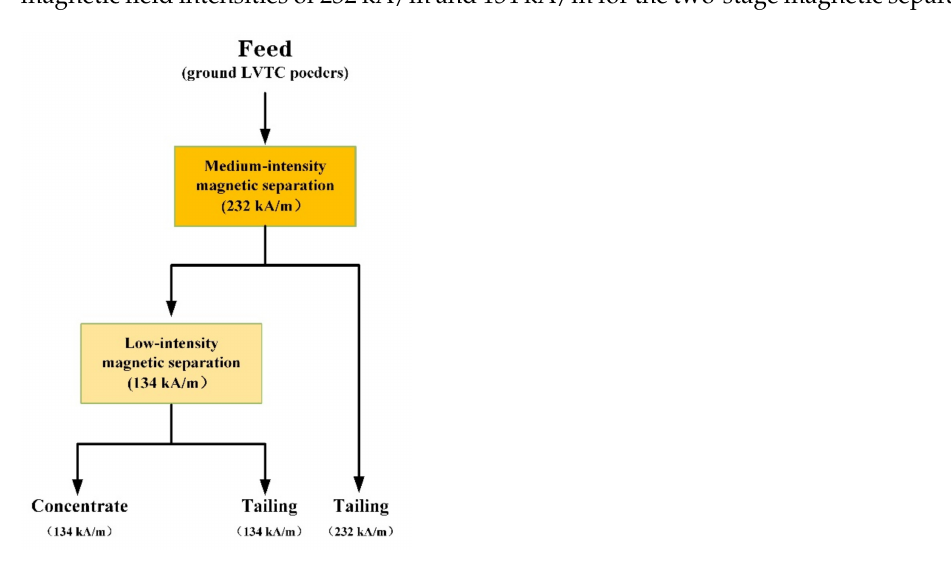
Figure 10. Flowchart of the magnetic separation process of ground LVTC